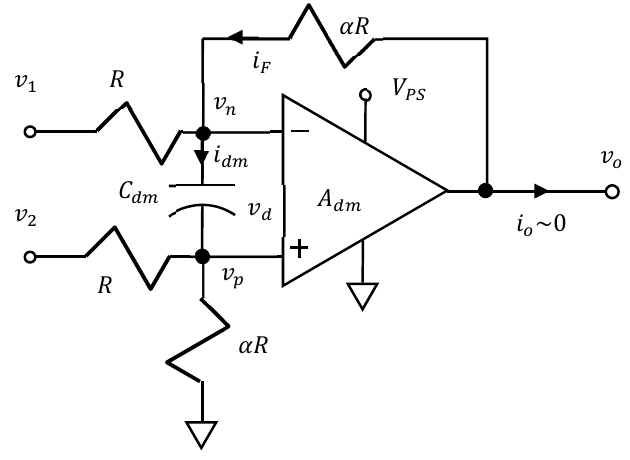
Figure 7. The dCCDA circuit.